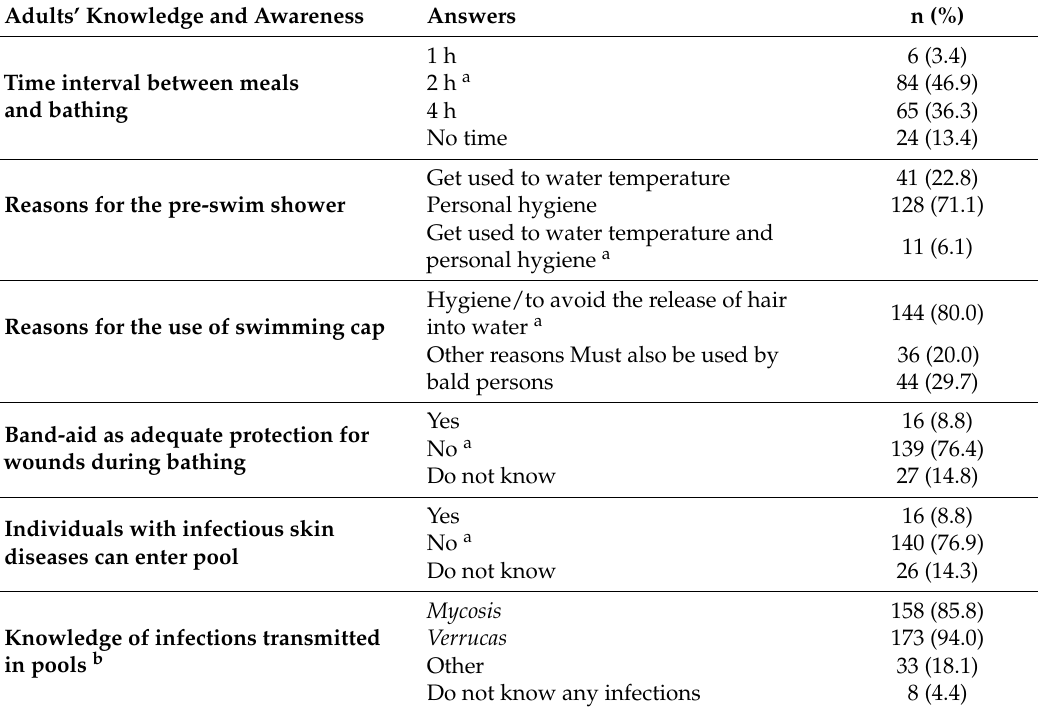
Table 3. Knowledge of health risks related to the attendance of swimming pools reported by adults ( n =